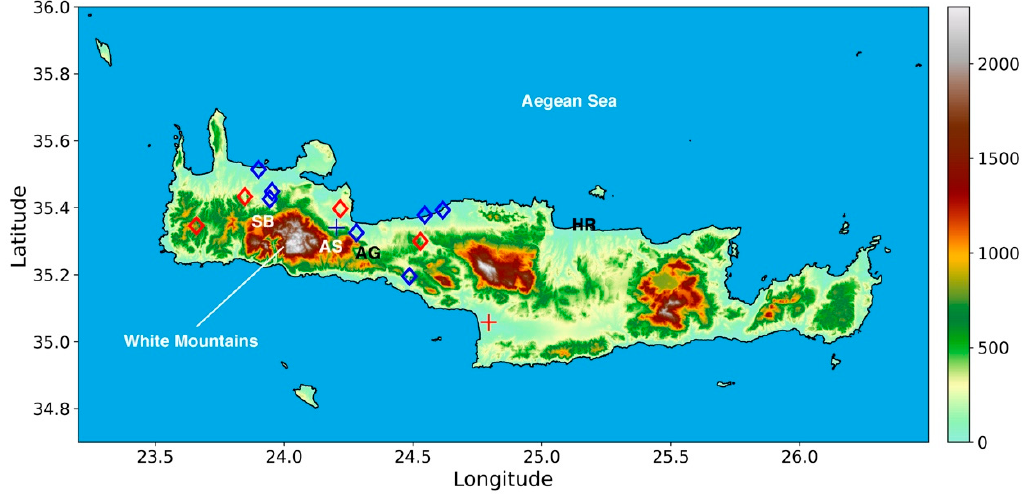
Figure 1. Main topographic features of Crete (shading). The red diamonds show the location of the main damages during the first storm (Chioni) and the blue diamonds during the second storm (Oceanis). Crosses denote the location of drownings. Three weather stations, Askyfou, Asigonia, and Sebronas, are also labeled (AS, AG, SB, respectively). HR denotes the position of Heraklion airport.